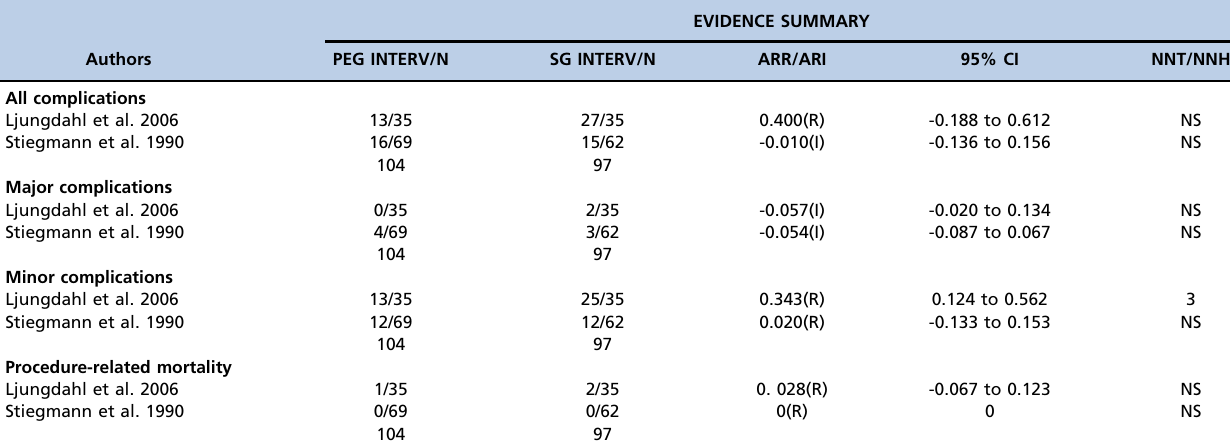
Table 3 - Statistical summary of complications and mortality for randomized